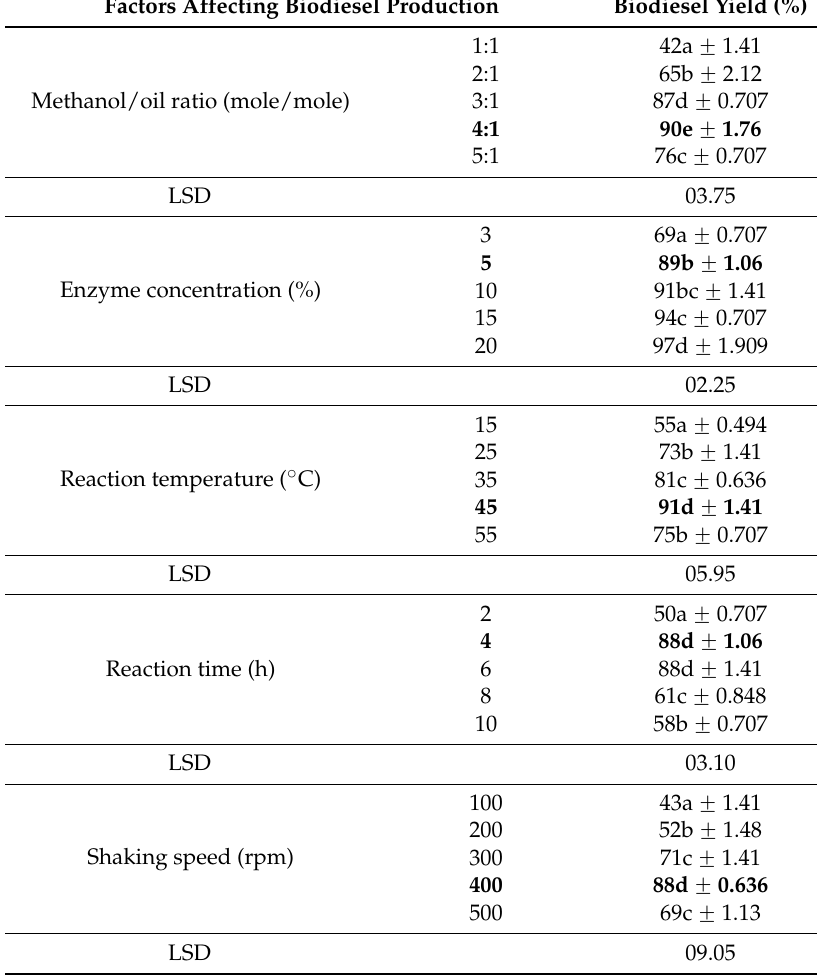
Table 3. Factors affecting biodiesel production using transesterification